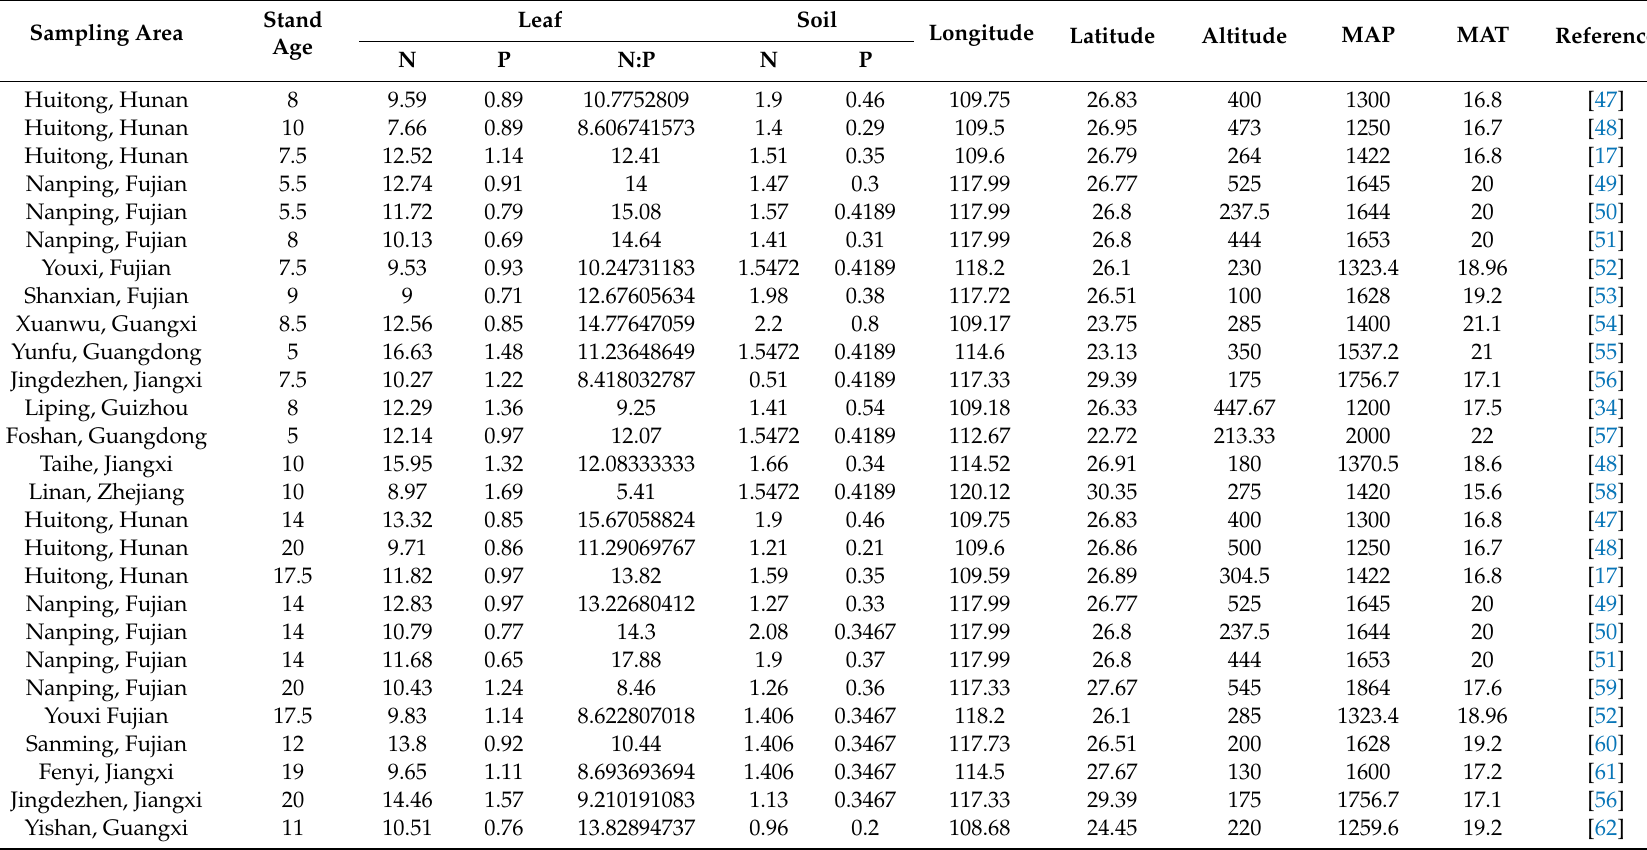
Table A1. References list with associated information on leaf and soil chemical concentrations, and geographical and climatic